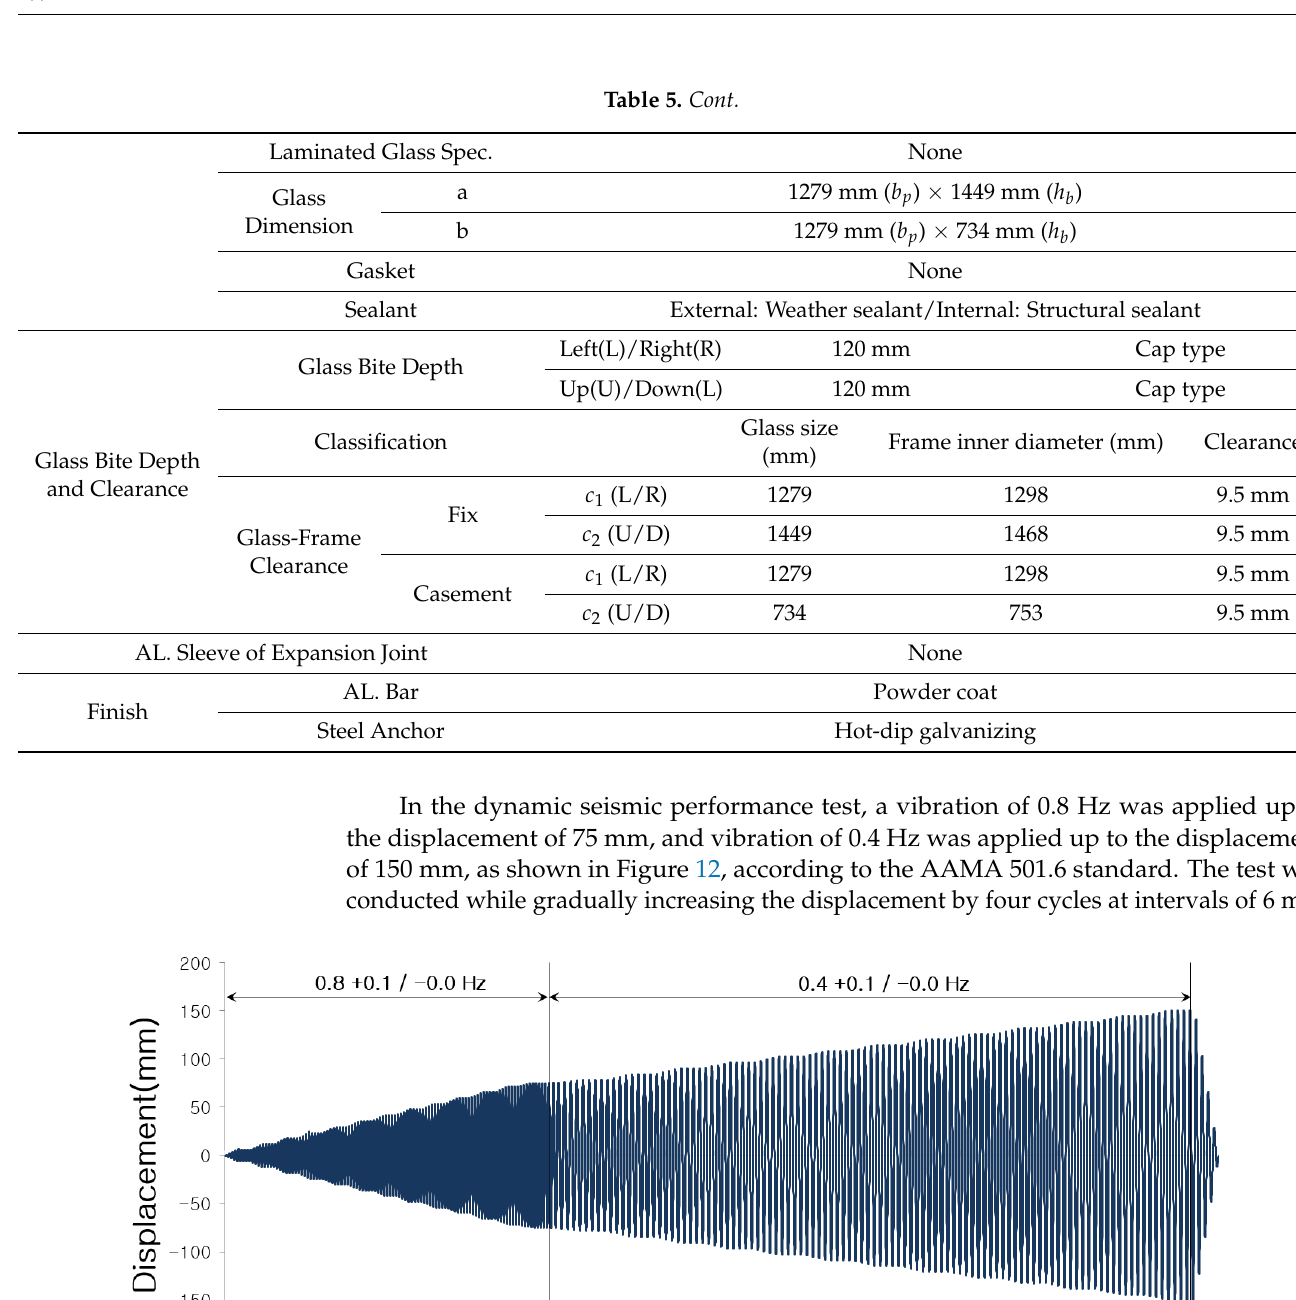
( c ) Figure 13. States of non-seismic curtain wall after the dynamic racking crescendo test: ( a ) silicone cracks (42 mm); ( b ) glass cracks (60 mm); ( c ) glass fallout (90 mm).